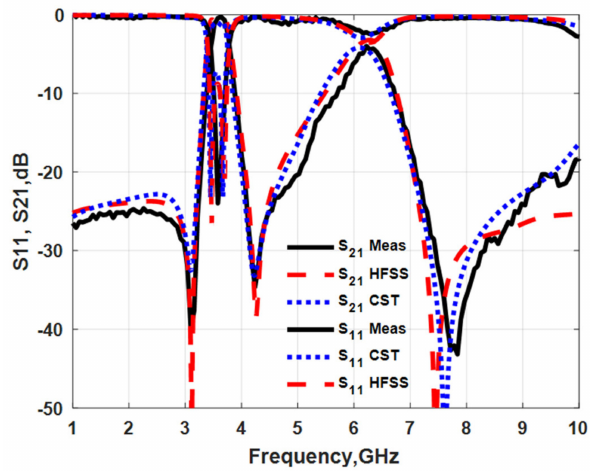
Figure 10. S 11 , S 21 simulated and measured results of stub loaded OLR with 0 ◦ feed BPF.